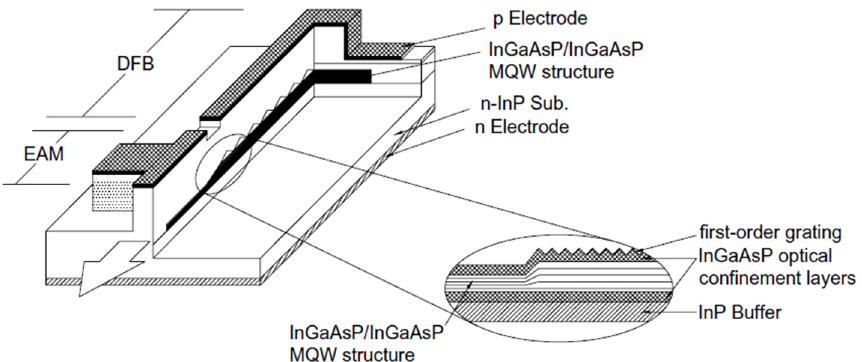
Figure 21. Ridge-waveguide EML consisting of a DFB laser and EAM. The enlarged portion shows the MQWs and interface of the EAM and laser regions. Reprinted with permission from ref. [82] © IOP Publishing. Copyright 2005 Semiconductor Science and